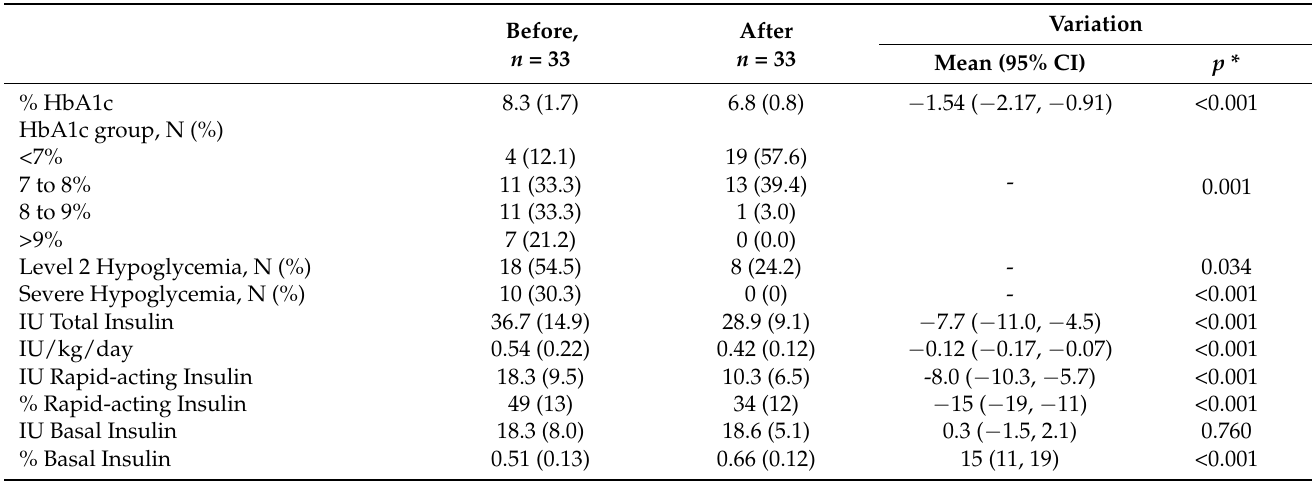
Table 4. Glycometabolic control and therapeutic data of the patients before and after EVLCD. Continuous variables are summarized with mean and standard deviation. Categorical variation are summarized as count (N) or percentage (%).